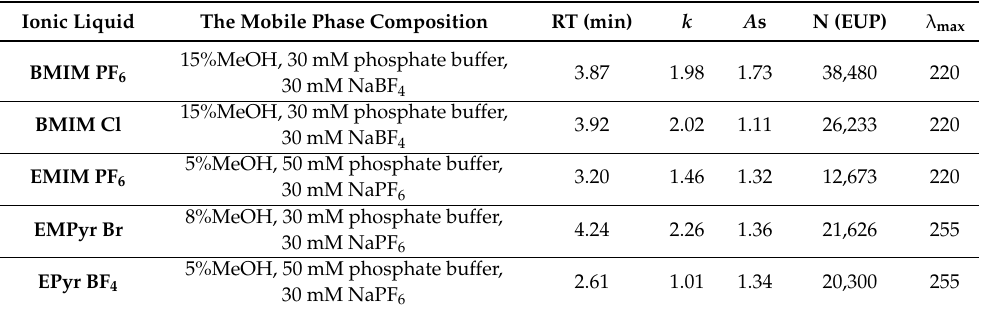
Table 2. The mobile phase components suitable for HPLC analysis of appropriate ionic liquids on a Zorbax Extend-C18 column.